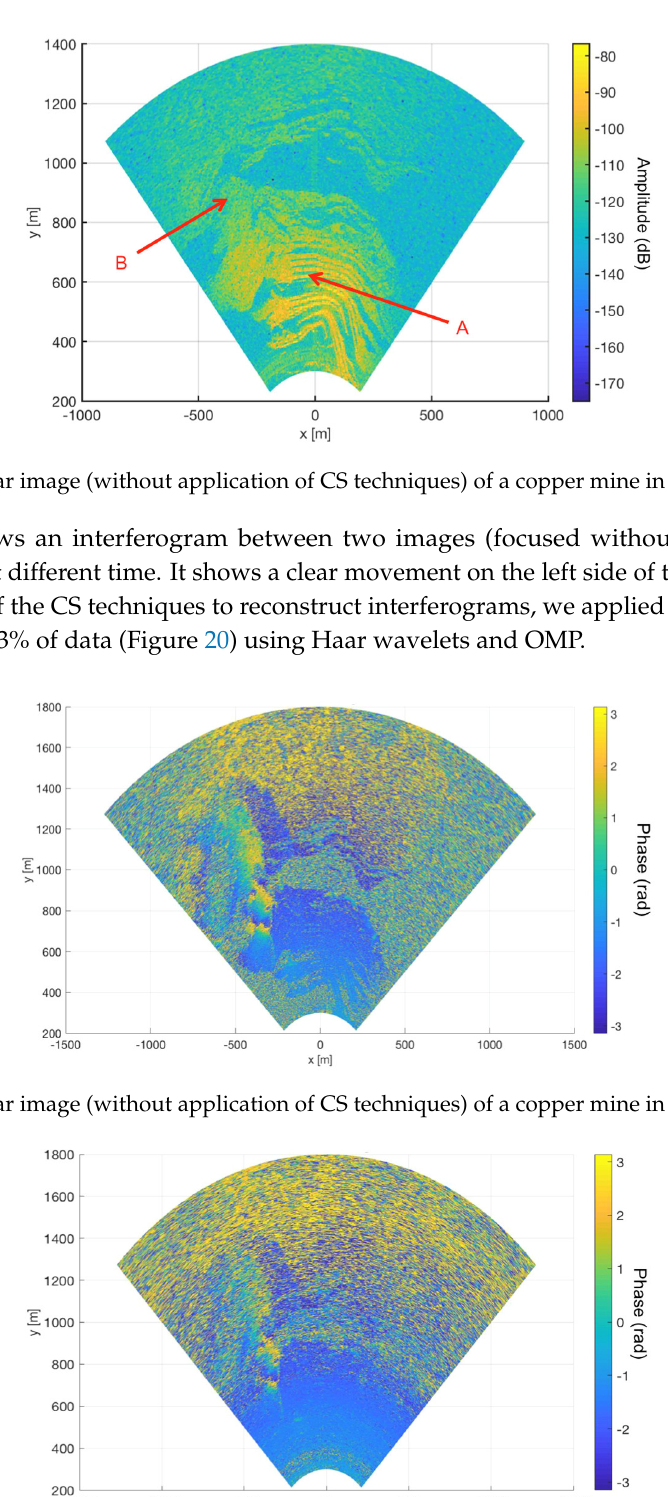
Figure 19. Radar image obtained with 50% of data and CS.